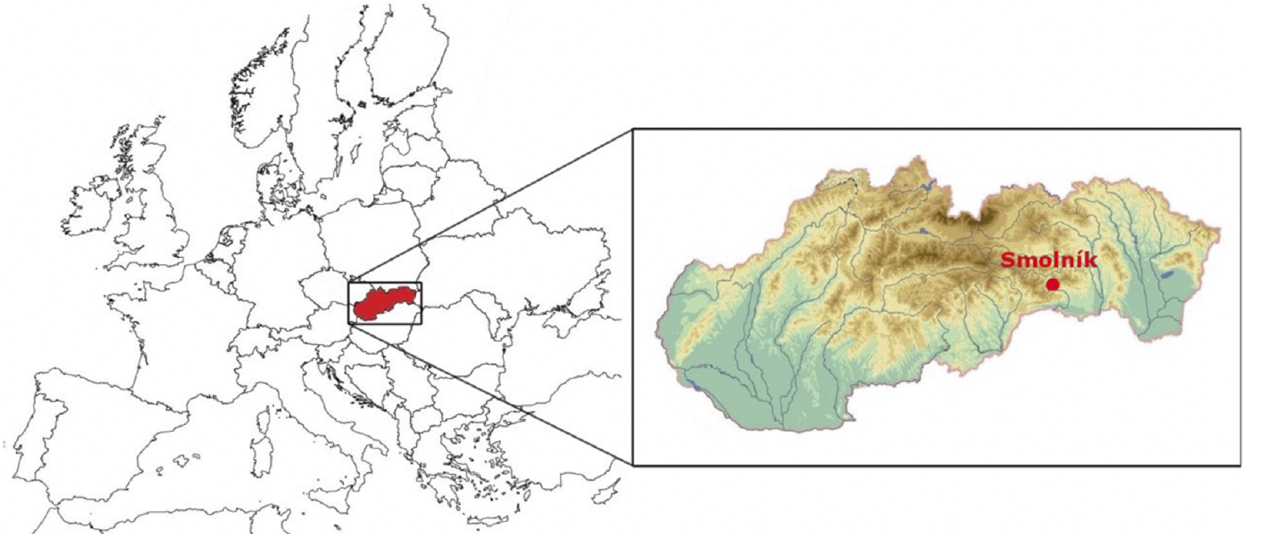
Figure 1. Location of the mining town Smolník within Slovakia and